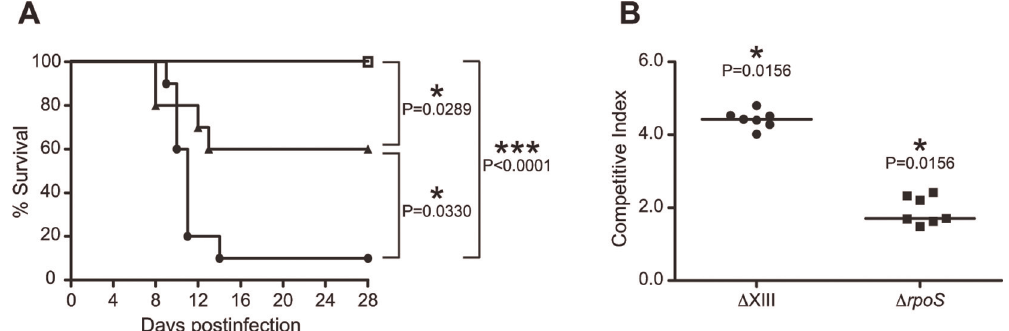
Fig 2. The synergic effect of the absence of RpoS and c-di-GMP signaling in Δ XIII strain results in high virulence attenuation. (A) Comparative lethality between wild-type (black circles), Δ rpoS (black triangles) and Δ XIII (open squares) strains in an oral infection mouse model. Groups of ten mice were orally infected with 10 7 cfu/ mouse. P-values were determined by a Log-rank (Mantel-Cox) test. (B) CI analysis following intragastric inoculation of seven BALBc mice with a 1:1 mixture of wild type and Δ XIII or Δ rpoS strains (total inoculum administered was 2 x 10 7 cfu). Mice were sacrificed after seven days and bacteria were enumerated from spleens. CI for the wild type and mutant strains was defined as stated in Fig 1